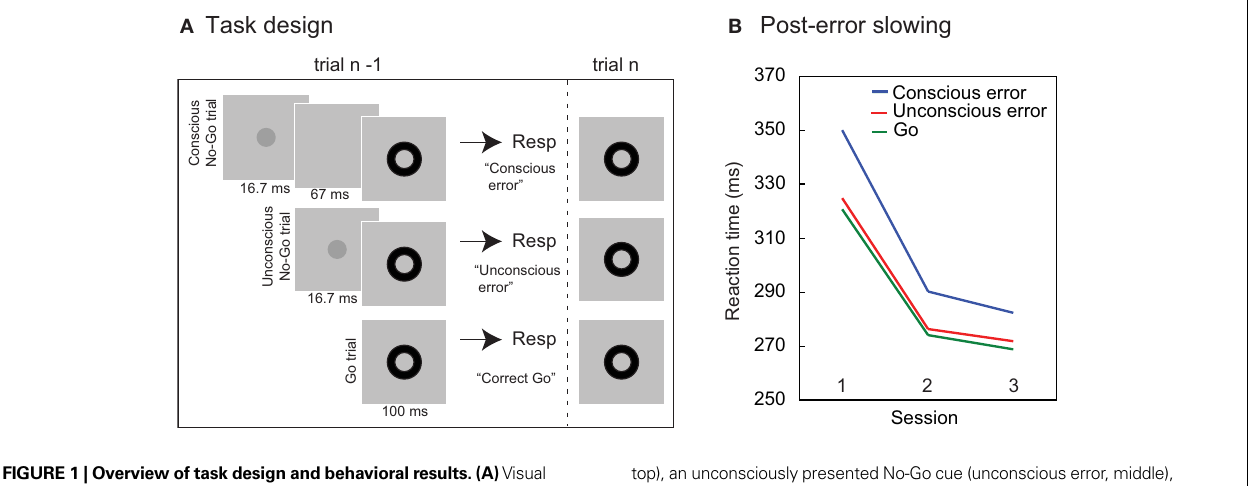
FIGURE 1 | Overview of task design and behavioral results. (A) Visual representation of trial events for the three conditions. Note that all data reported here are from correctly responded Go trials (“trial n ”) in which the previous trial also contained a response, separated according to whether the previous trial contained a consciously visible No-Go cue (conscious error,